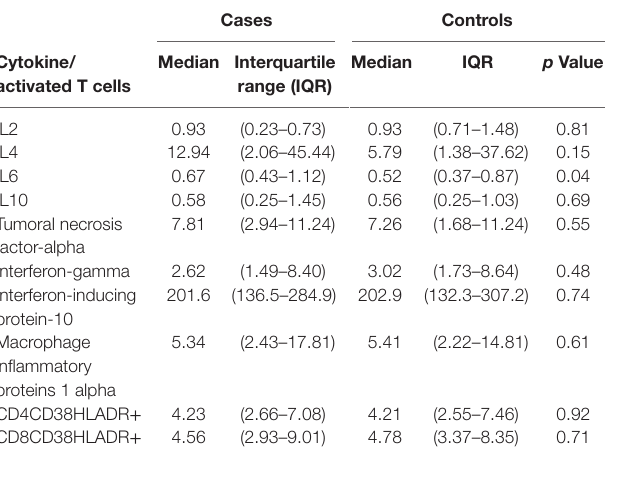
TaBle 3 | Frequency of CD4CD38HLADR + , CD8CD38HLADR + cells (%), and serum levels of eight cytokines (pg/mL) in cases and